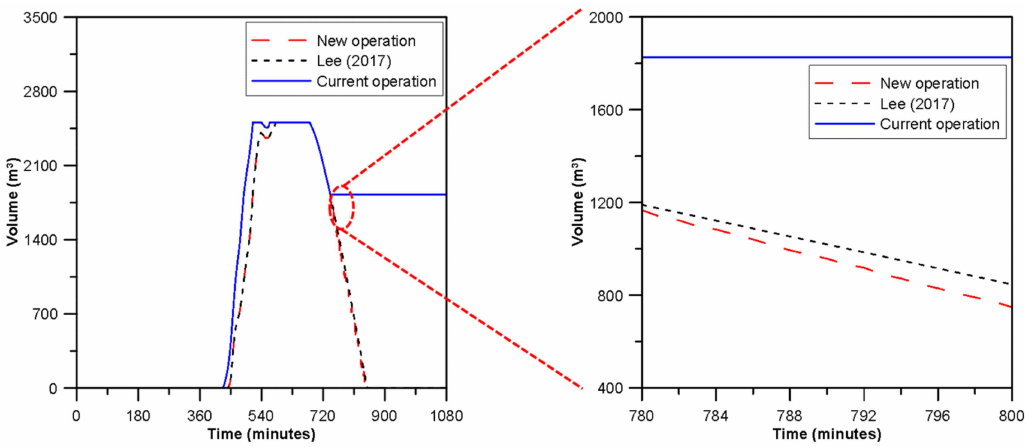
Figure 12. Volume of the decentralized reservoir in 2010 [1].